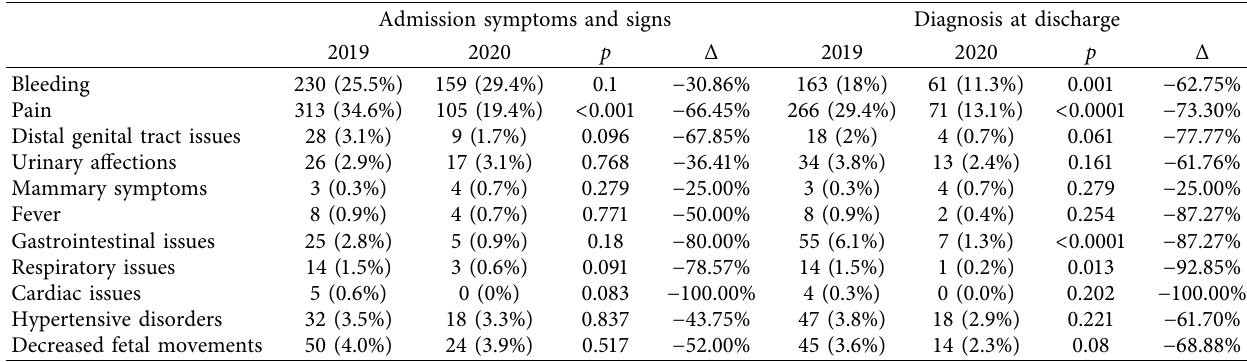
Table 5: Obstetrical patients’ admission and discharge.